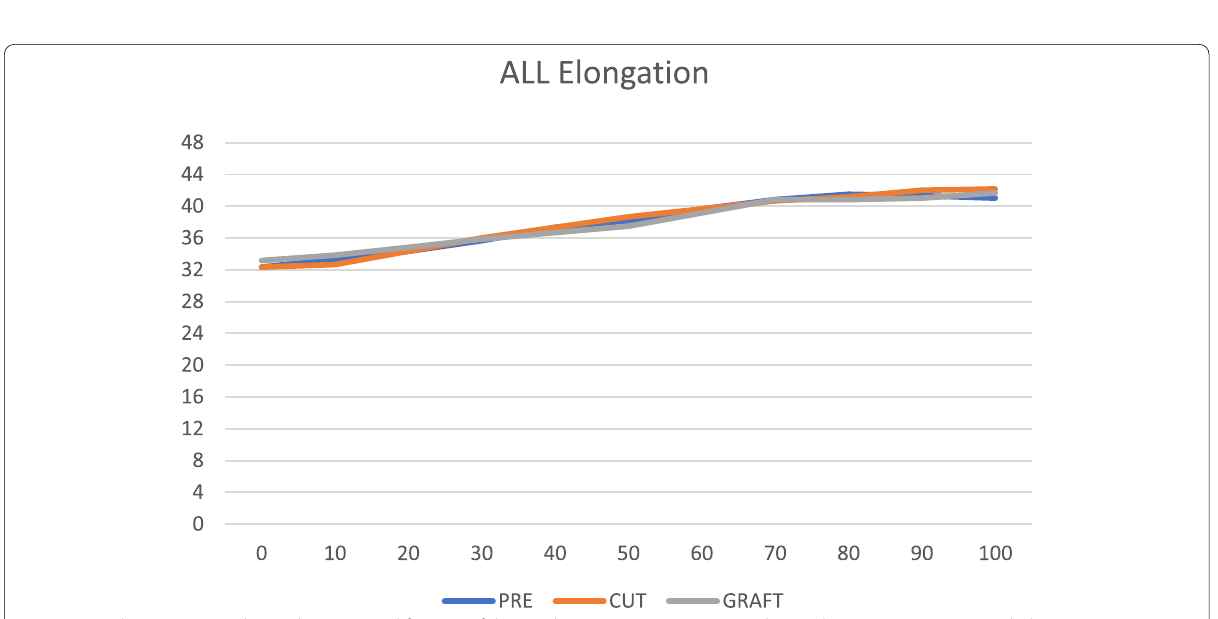
p < .05) and reduced VV30 (* p < .05) = =